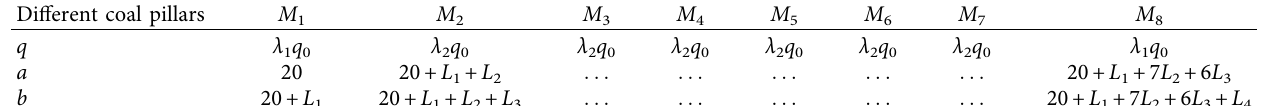
Table 2: Loading and geometric parameters of different zones in the gob of the coal seam 2 − 2 . Different coal pillars